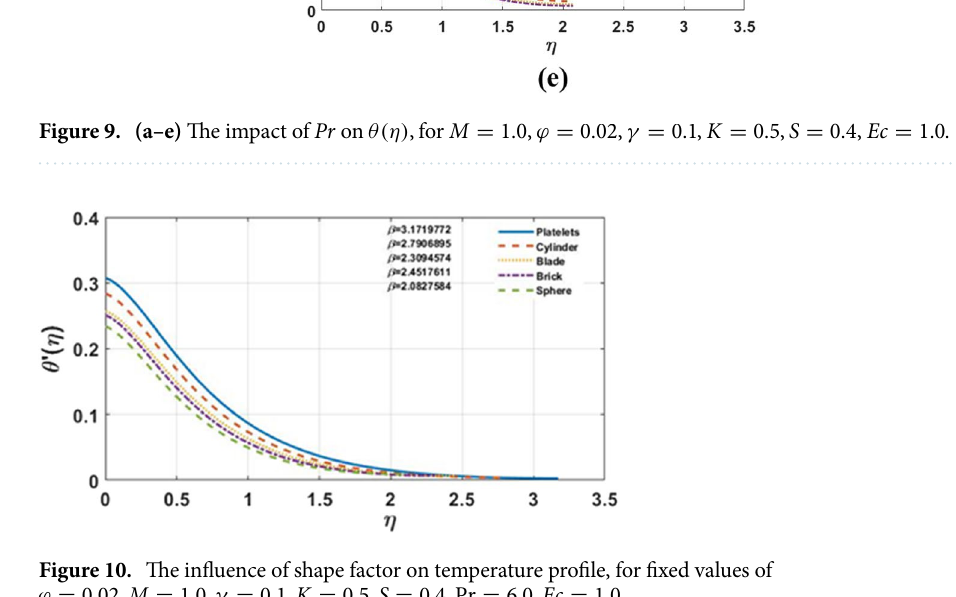
Figure 10. The influence of shape factor on temperature profile, for fixed values of 0.02, M 1.0, γ 0.1, K 0.5, S 0.4, Pr 6.0, Ec 1.0 ϕ = = = = = = =